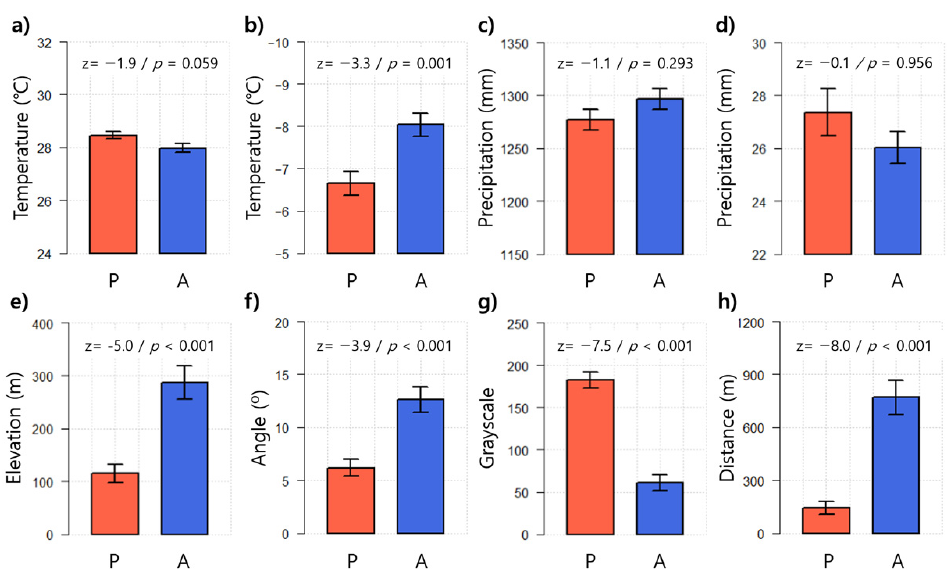
Figure 2. Comparison of environmental conditions between the presence (P) and absence (A) sites of WCSBs. The z-score (z) and p -value ( p ) were calculated based on test statistics (U) of the Mann– Whitney U test. The bars and error bars represent the mean and standard error of each variable. ( a ) Maximum temperature of the warmest month, (b) minimum temperature of the coldest month, ( c ) annual precipitation, ( d ) precipitation of driest month, ( e ) elevation, ( f ) slope, ( g ) night light, ( h ) distance to the road. Furthermore, using nonparametric correlation analysis, some strong relationships between environmental conditions were found in the WCSB habitats (Figure 3). Strongly positive relationships ( r > 0.5, p < 0.05) were observed between elevation and slope. Strongly negative relationships ( r < − 0.5, p < 0.05) also appeared between the minimum temperature of the coldest month (Bio6) and elevations.